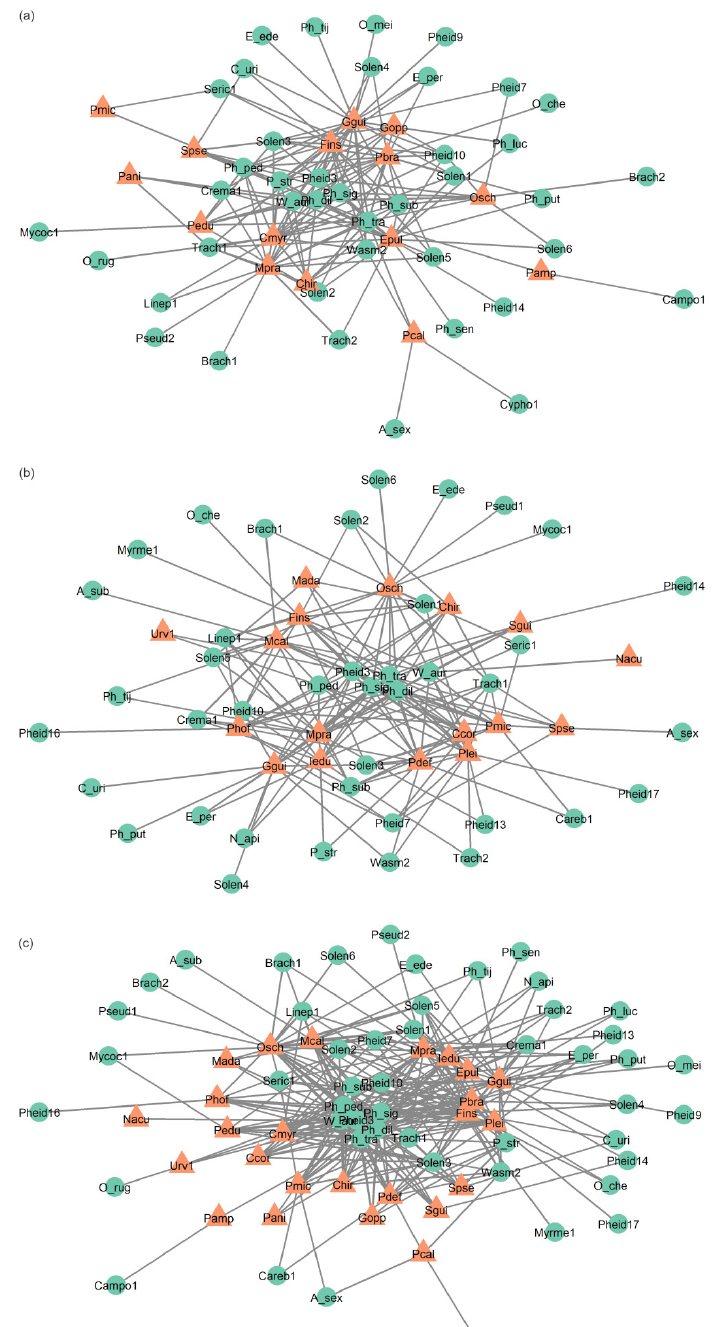
Fig 1 . Network of interactions between diaspores and ant species. Plants are represented by triangles, and ants by circles. Lines represent ant-diaspore interactions. (a) Dry-season network. (b) Rainy-season network. (c) Total network. The ant codes are in Table 2. Cmyr = Citharexylum myrianthum ; Chir = Clidemia hirta ; Ccor = Coccocypselum cordifolium ; Epul = Erythroxylum pulchrum ; Fins = Ficus insipida ; Gopp = Guapira opposita ; Ggui = Guarea Guidonia ; Iedu = Inga edulis ; Mcal = Miconia calvescens ; Mpra = Miconia prasina ; Mada = Monstera adansonii ; Nacu = Niedenzuella acutifolia ; Osch = Ocotea schottii ; Pedu = Passiflora edulis ; Pmic = Paulinia micrantha ; Pamp = Piper amplum ; Pani = Piper anisum ; Pcal = Piper caldense ; Pbra = Protium brasiliense ; Phof = Psychotria cf. hoffmannseggiana ; Pdef = Psychotria deflexa ; Plei = Psychotria leiocarpa ; Sgui = Siparuna guianensis ; Spse = Solanum pseudochina ; Urv1 = Urvillea